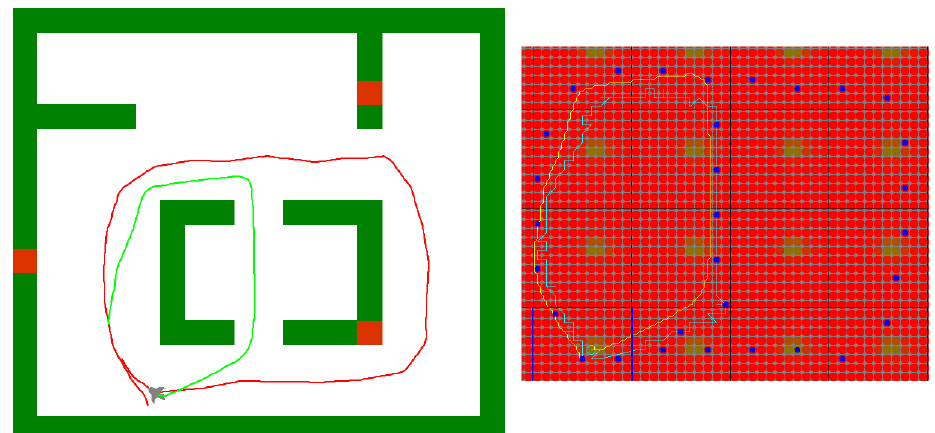
Figure 15. Forward navigation with shortcut finding system. First and last place cell are disconnected. The agent moves towards the most distant place cell that it can observe, and when it passes close to the shortcut, it observes a place cell that is very close from the destination place cell, and turns to take the shortcut. The agent then creates a new sequence of place cell until it reaches the destination place